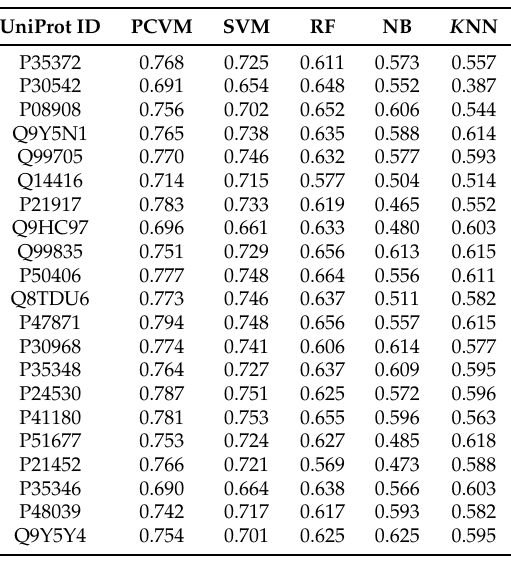
Table 5. Performance comparison of target prediction methods in terms of Matthews Correlation Coefficient. Scores for the external test